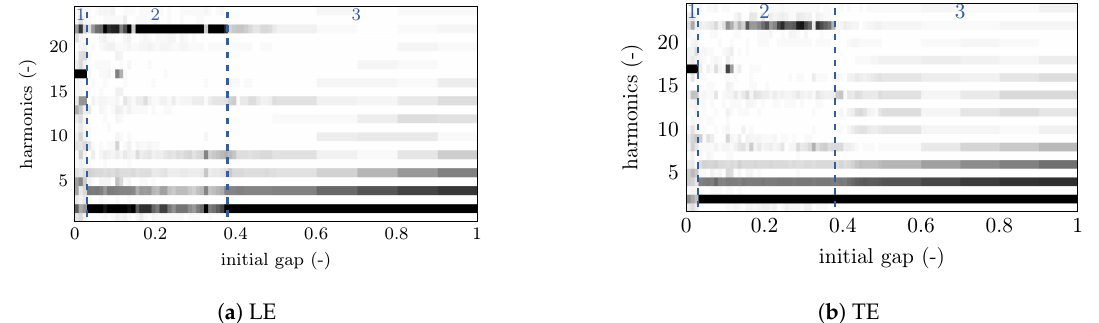
Figure 22. Evolution of the space Fourier transform of the wear profile with the initial clearance for the HP compressor blade.